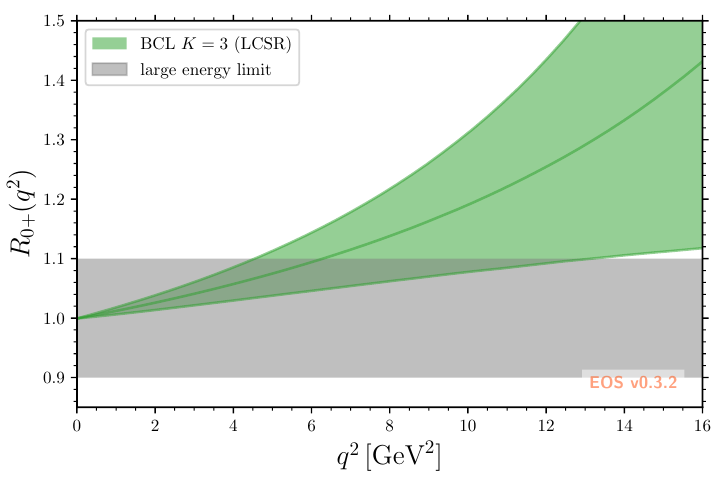
Figure 4 . The ratio of form factors R 0+ ( q 2 ) as defined in the text. We extrapolate based on the fit to LCSR pseudo data and compare with the symmetry limit (3.10), which is valid for large π energy in the B -meson rest frame or equivalently at small q 2